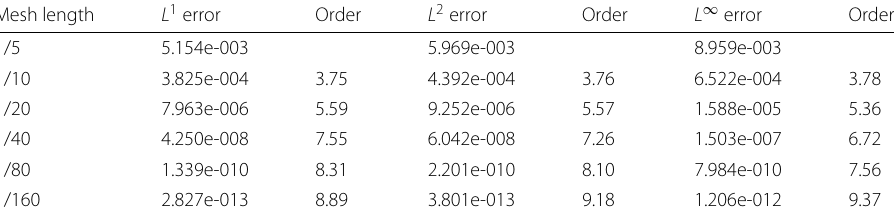
Table 4 1-D accuracy test: errors and convergence orders of 8th-order compact nonlinear scheme with (cid:10) t = 0.3 (cid:10) x 2